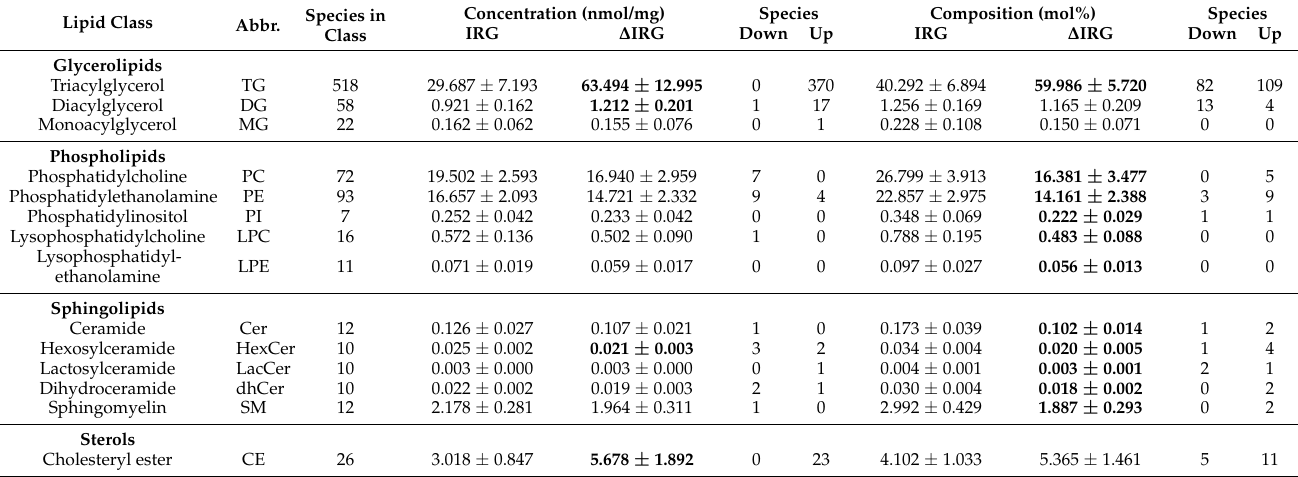
analysis on the 16-h fasted animals. Table 1. Hepatic lipid content in mice with reduced lipophagy (ΔIRG) compared to control mice (IRG) after a 16-h fast. Absolute (concentration, nmol/mg) and relative (composition, mol%) values for individual lipid classes are presented. Data are shown as means ± SD and analyzed by unpaired t-test with Welch’s correction. Significant values ( p < 0.05) are bold. IRG, n = 7; ΔIRG, n = 7.